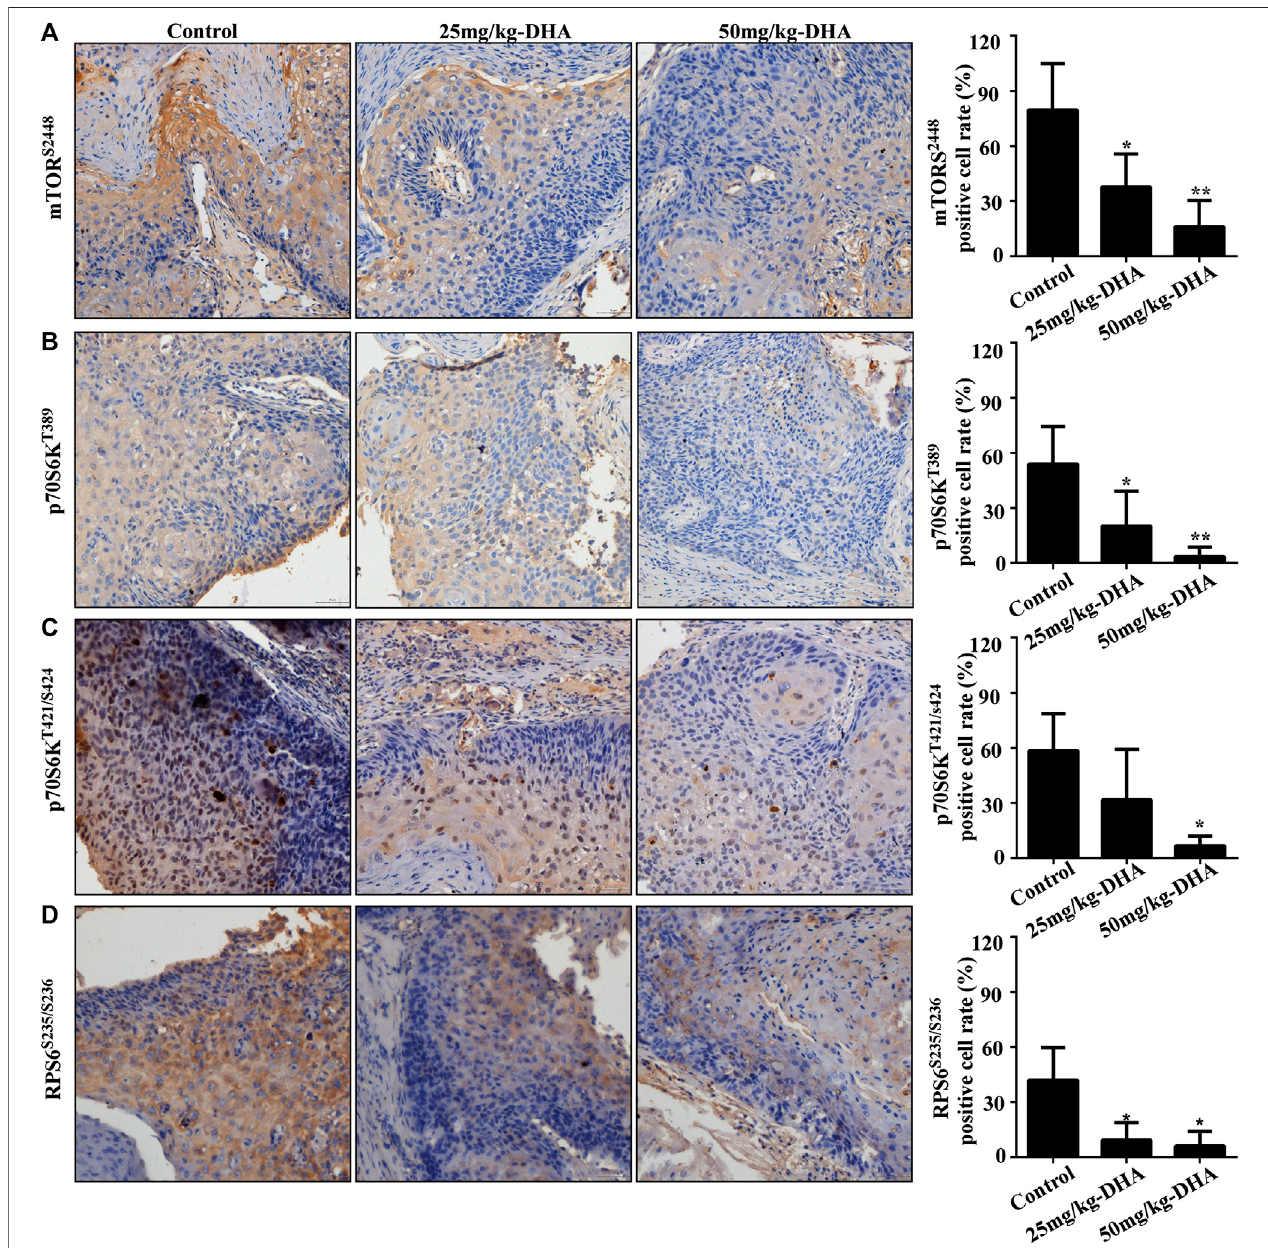
FIGURE 6 | DHA suppresses the phosphorylation of mTOR S2448 , p70S6K T389 , p70S6K T421/S424 , and RPS6 S235/S236 in the LEG20 xenograft mice model, con fi rmed using IHC analysis. (A – D) DHA inhibited the levels of mTOR S2448 (A) p70S6K T389 (B) p70S6K T421/S424 (C) and RPS6 S235/S236 (D) in the LEG20 xenograft tumors.Representativeimagesofeachgroupareshown.AllthesectionswerescannedusingTissueFAXS(400 × ),andthepositivecellswereanalyzedusingHistoQuest 4.0 software (*, p < 0.05; **, p < 0.01; ***, p < 0.001; n (cid:2) 6 per group, one-way ANOVA).